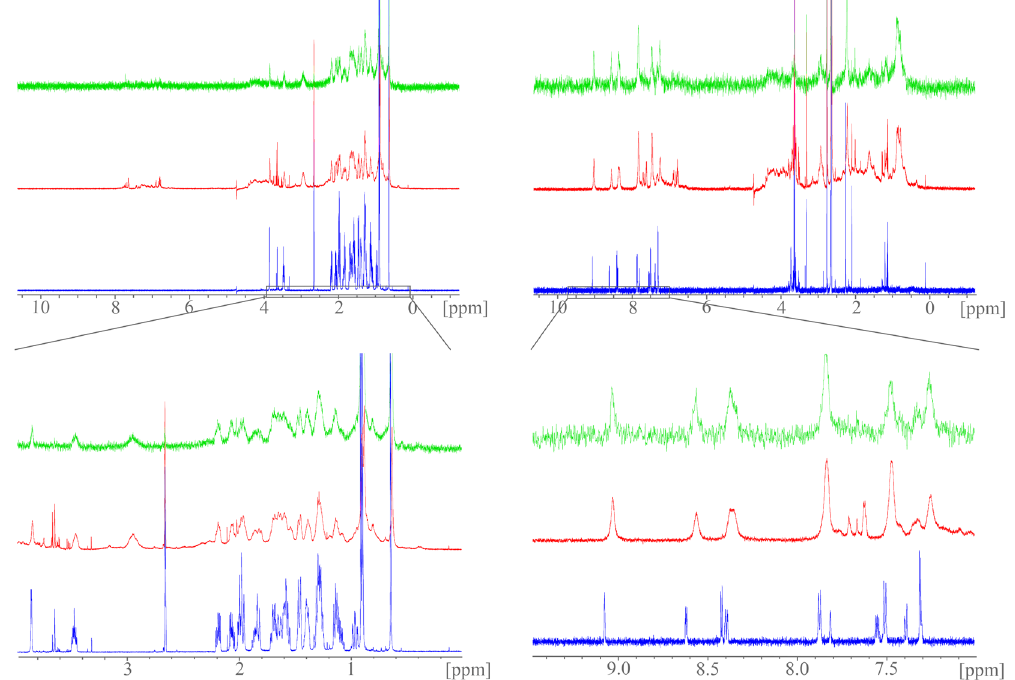
Figure 2. Saturation-transfer difference (STD) NMR experiments confirm binding of 4 to the FXR-LBD: STD-NMR experiments with CDCA ( 1 , left spectra) or imatinib ( 4 , right spectra) and the FXR-LBD; the upper spectra are covering the full recorded range, the lower magnifications depict the relevant areas; standard 1 H-NMR spectra of compound alone are depicted in blue, standard 1 H-NMR spectra in presence of the FXR-LBD are red and STD-NMR spectra are green: 1 H-NMR signals of 1 and 4 are significantly broadened upon addition of FXR-LBD protein. Additionally, signals of 4 show chemical shift perturbations. When the protein is saturated in the STD experiment (green), magnetization is transferred to 4 indicated by appearance of the same broad aromatic signals of 4 which confirms binding of 4 to the